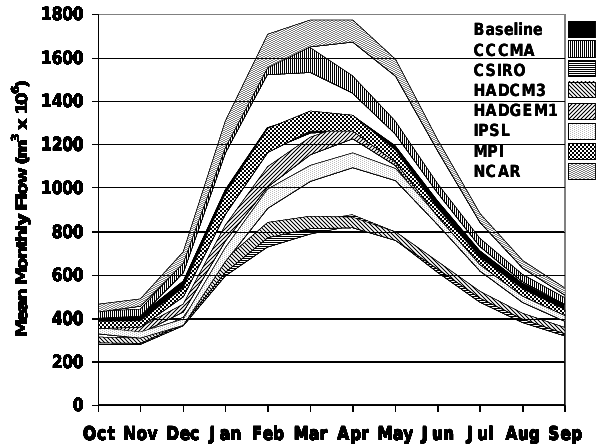
Fig. 9. Deviations, relative to the baseline conditions, of mean Figure 9 Deviations, relative to the baseline conditions, of mean monthly flow 898 monthly flow of the Okavango River at Mukwe for the total sim- of the Okavango River at Mukwe for the total simulation period for the 899 ulation period for the 7 7 GCMs. 900